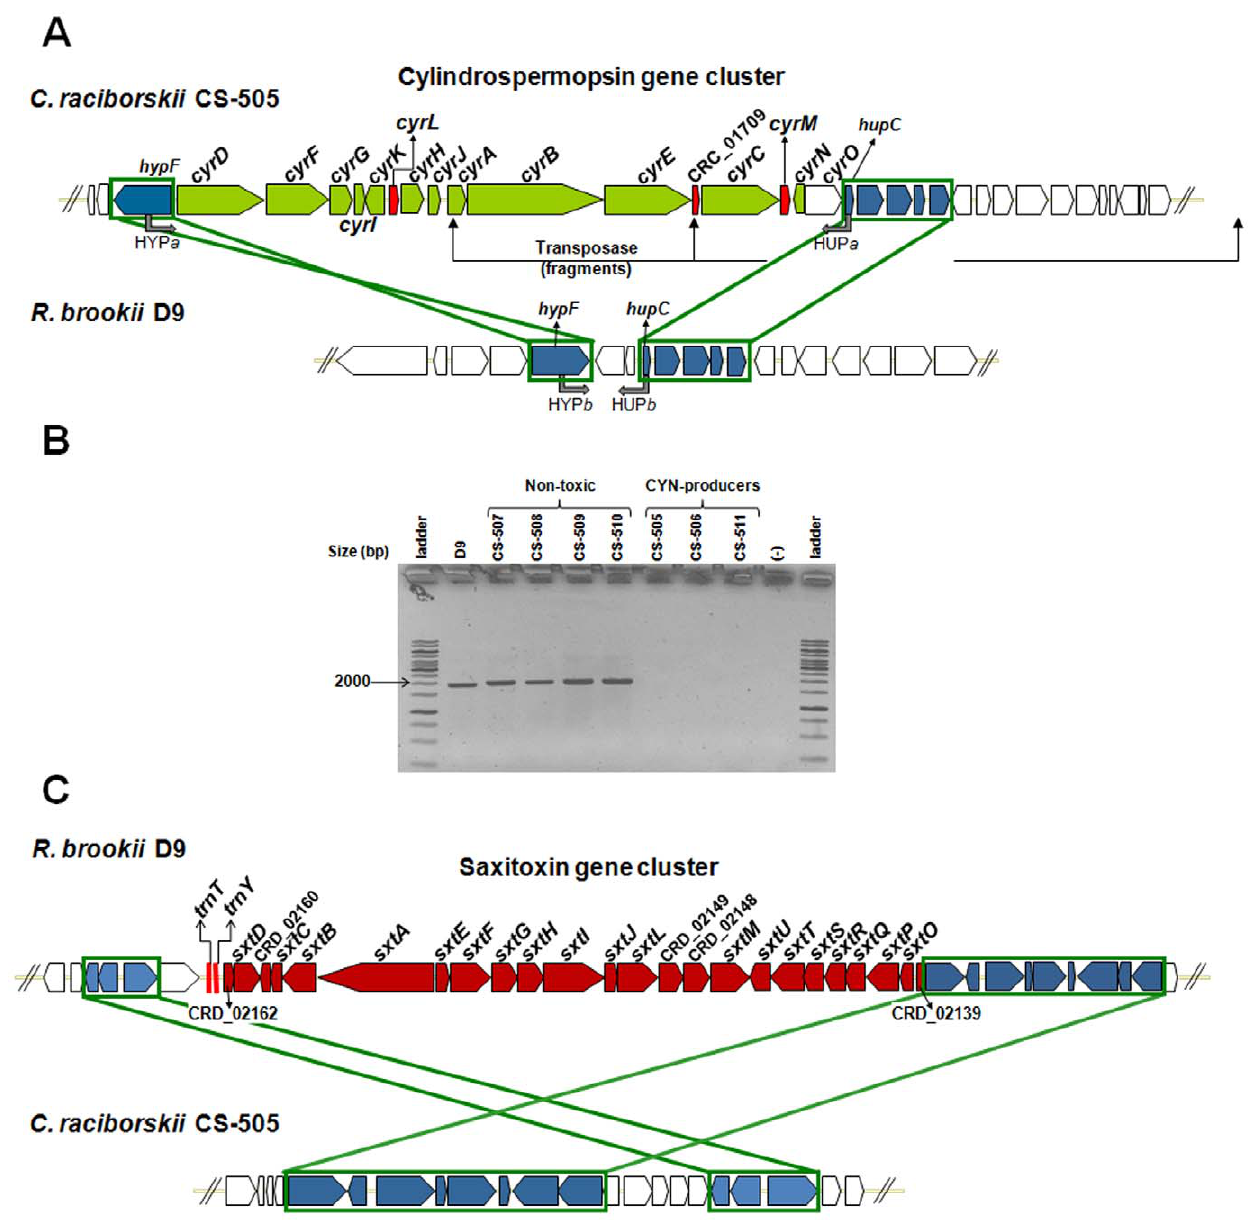
Figure 4. Schematic representation of the syntenic regions within the toxin gene clusters in CS-505 and D9. A. Location of the CYN gene cluster of CS-505 compared with the syntenic genomic region in D9. B. Gel electrophoresis of the PCR products from the hypF/hupC amplification in R. brookii D9 and in the strains of C. raciborskii non-toxic: CS-507, CS-508, CS-509 and CS-510. Producers of CYN: CS-505, CS-506 and CS-511 do not present amplification of the hypF/hupC region. C. Location of the STX gene cluster of D9 compared with the syntenic genomic region in CS-505. Genes participating in syntenic regions are depicted in blue and highlighted in the green boxes within the arrows; genes outside the syntenic regions are depicted in white. tRNAs and transposases are shown in red. The grey arrows show the position of the primer pairs HYPa/HUPa and HYPb/HUPb used to amplify the region between hypF and hupC genes in different strains of C. raciborskii and in R. brookii D9, respectively. Ladder: GeneRuler 1 kb DNA ladder (Fermentas, Ontario, Canada). The strains of C. raciborskii were obtained from the culture collection of the Commonwealth Scientific and Industrial Research Organization (CSIRO), Australia. For more details on DNA isolation, primer synthesis and PCR conditions see Methods